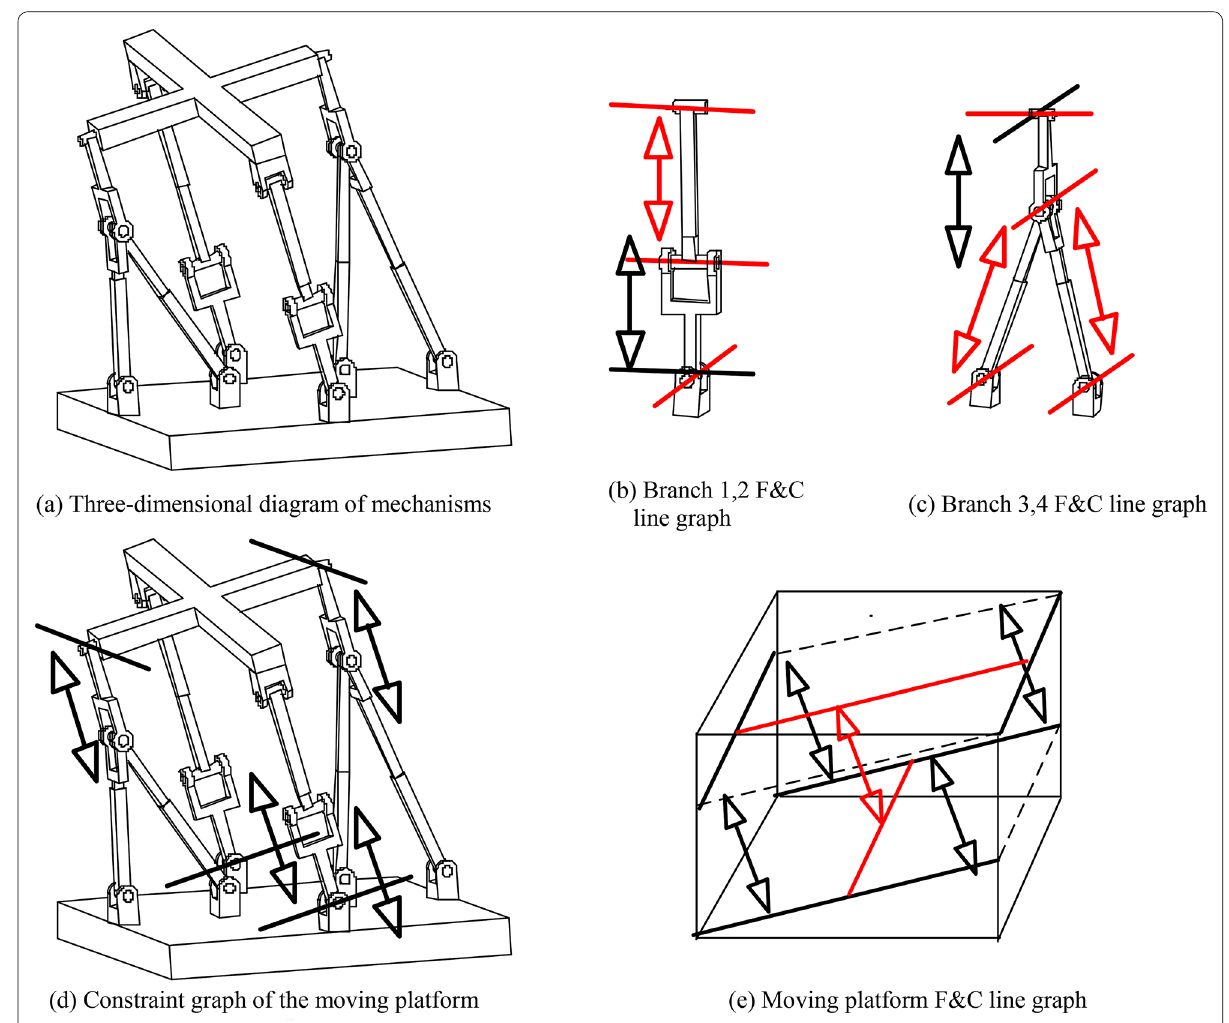
Figure 14 Correlated line diagram at general l position